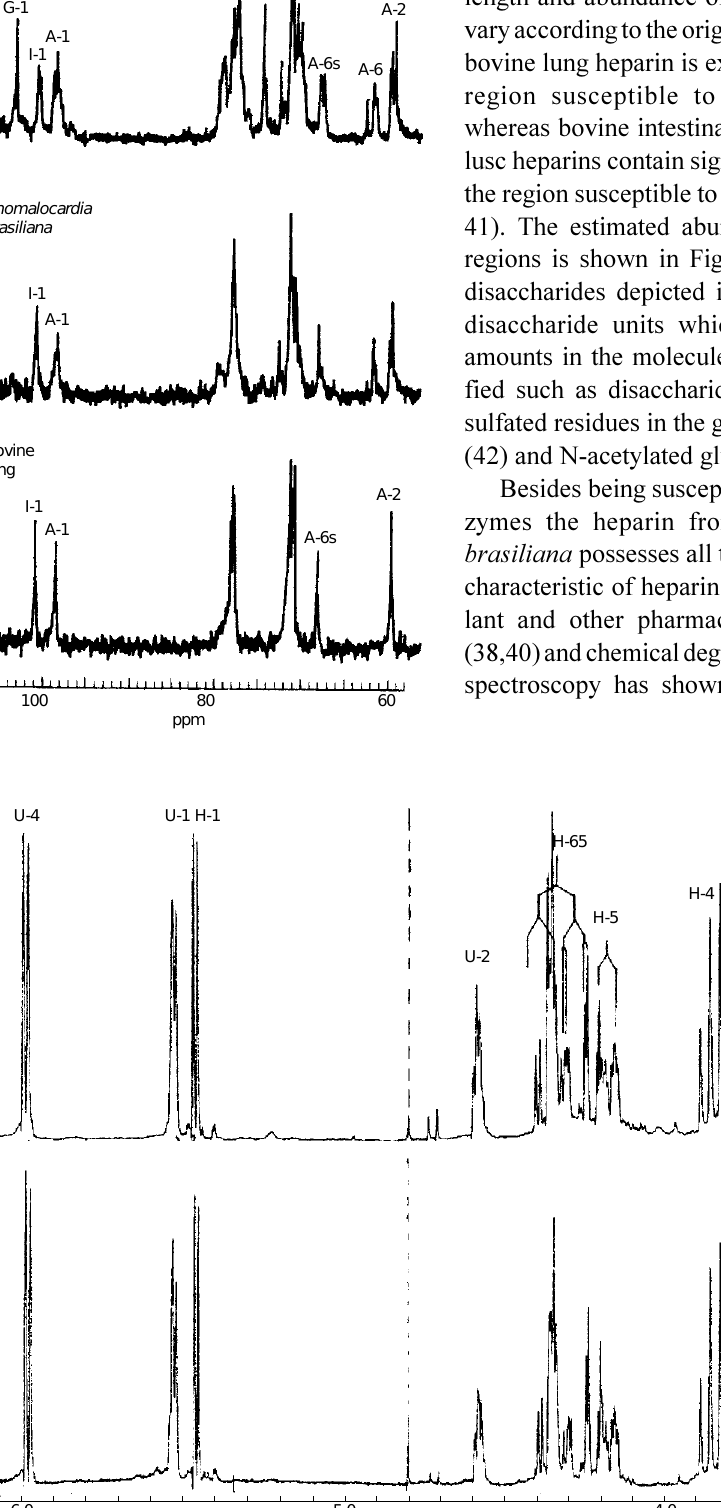
Figure 10 - [ 13 C]-NMR of mam- malian and mollusc heparins.